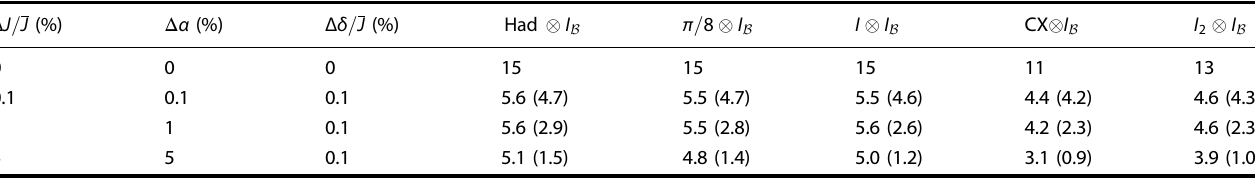
Table 1. Maximum worst-case fi